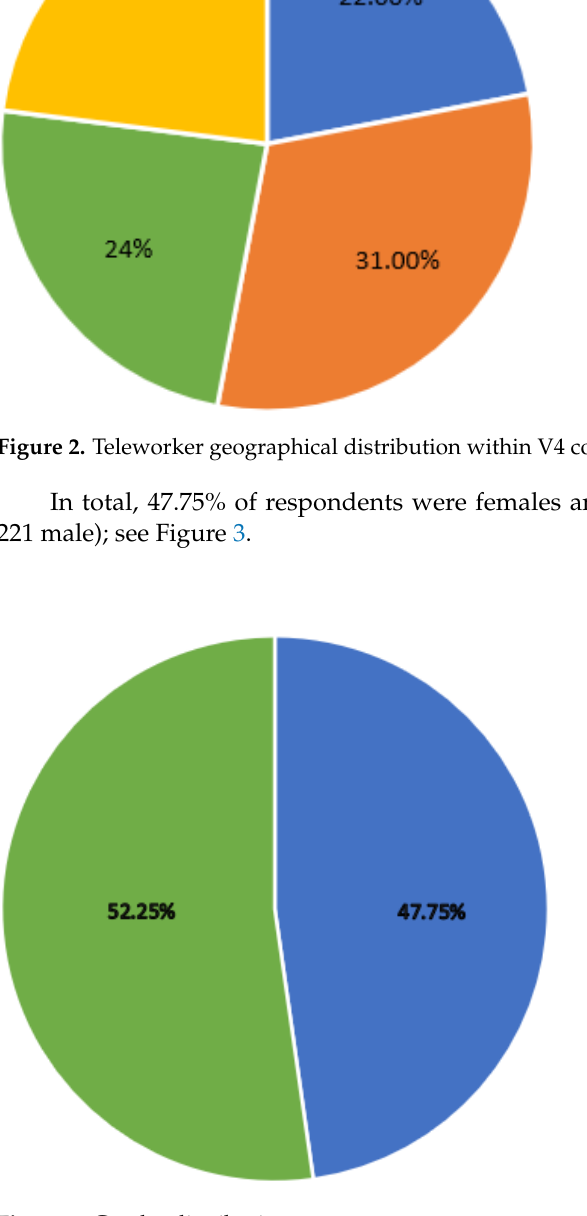
Figure 3. Gender distribution. Figure 3. Gender